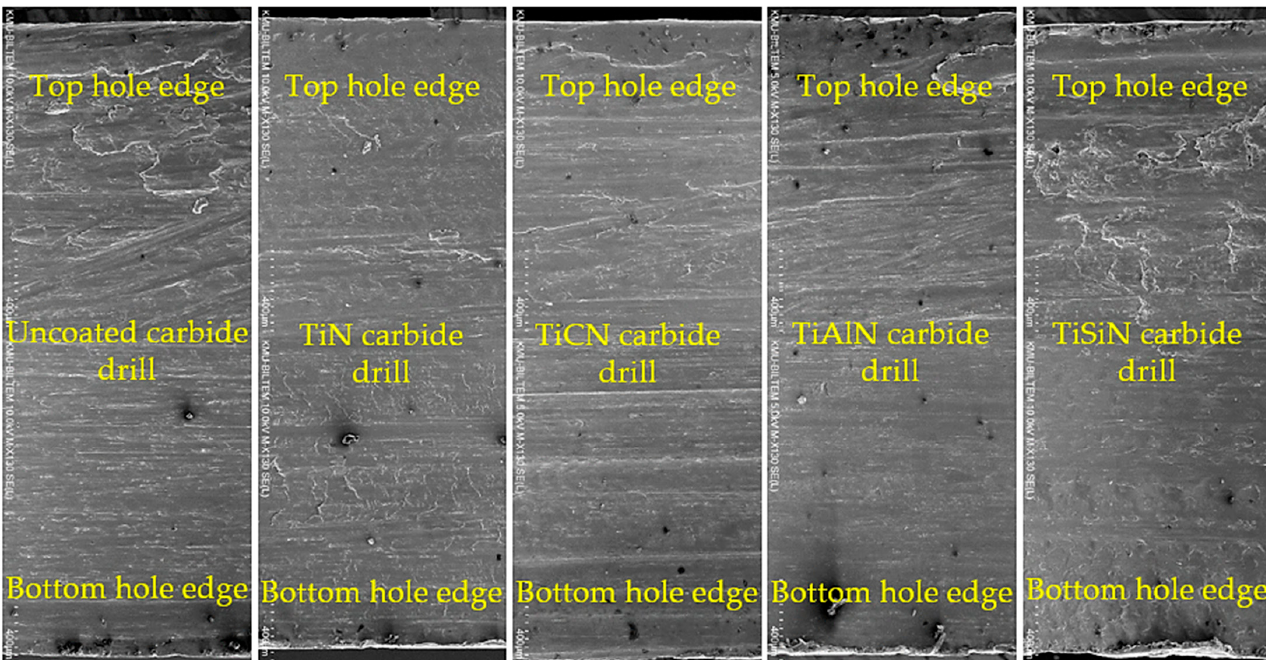
Figure 7. Top- and bottom-hole edges of the uncoated and coated carbide drills .